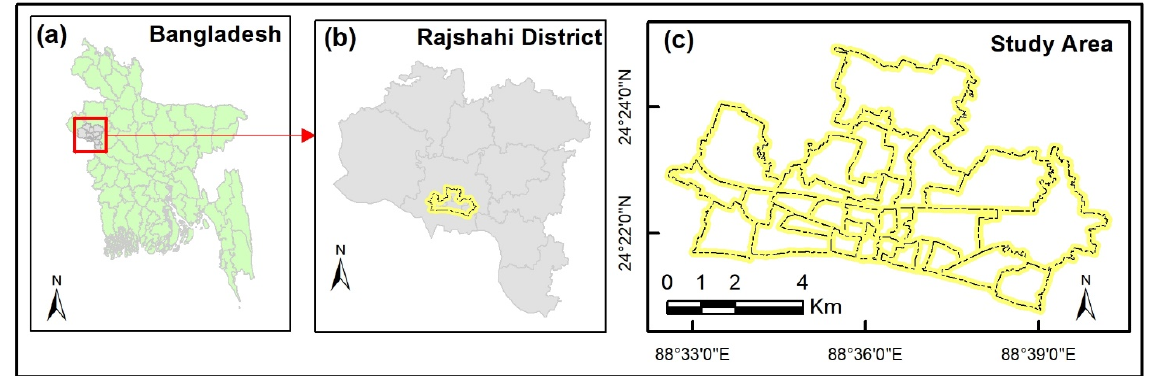
Figure 1. ( a ) Location Rajshahi district with respect to Bangladesh; ( b ) location of study area with respect to Rajshahi district; ( c ) administrative boundary of study area .